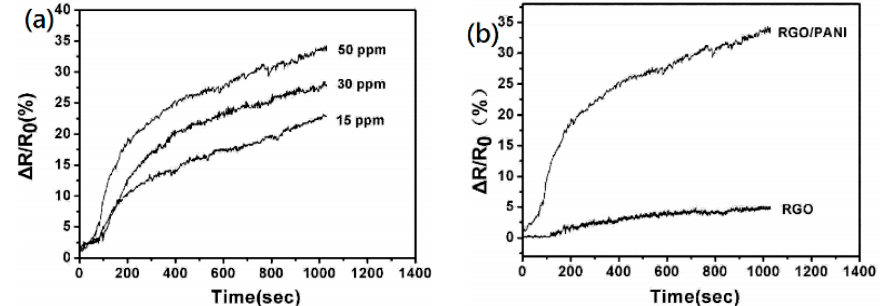
Figure 13. ( a ) Response curves of gas sensors based on graphene/polyaniline hybrid materials to different concentrations of NH 3 ; and ( b ) response curves of graphene/polyaniline hybrid materials and conventional redox graphene to 50 ppm NH 3 [79].